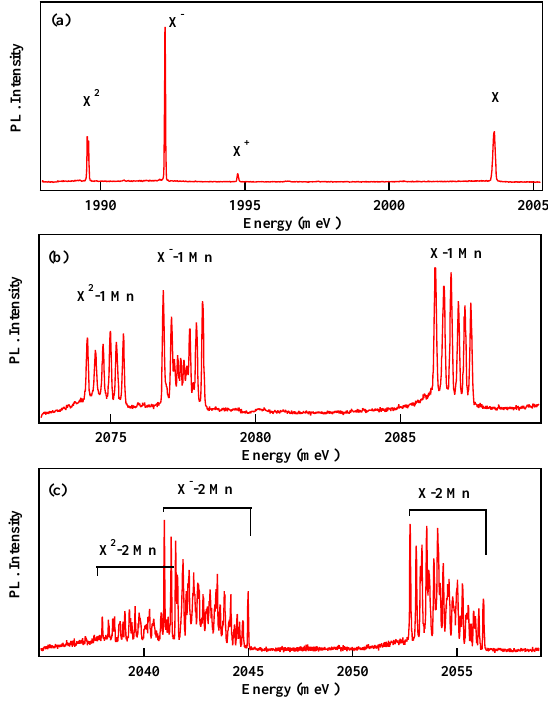
Figure 1: Low temperature (T = 5 K) PL spectra of three different CdTe/ZnTe QDs containing 0 (a), 1 (b) and 2 (c) Mn atoms and a variable number of carriers (one electron-hole pair (X), two electron- hole pairs (X 2 ), two electrons one hole (X − ) and one electron two holes (X + )). All the spectra are obtained under resonant excitation on an excited state of the